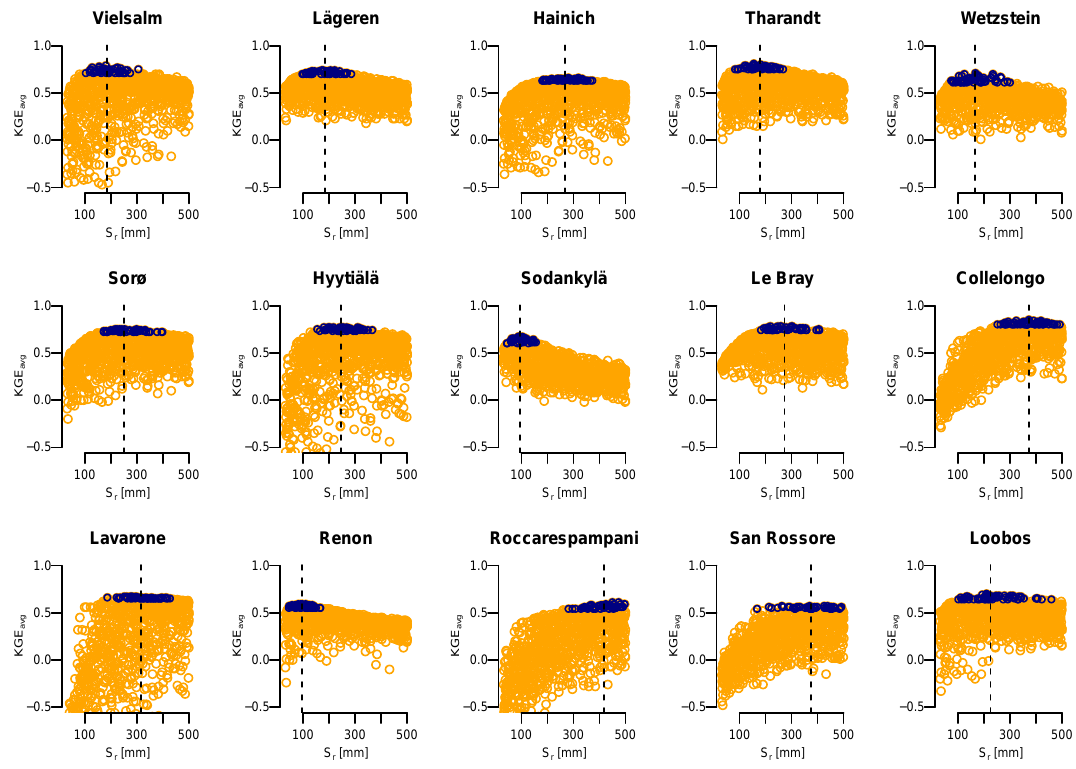
Figure 3. Relationship of the KGE avg obtained during calibration and the parameter values of S r . The dark blue points have a KGE avg greater than or equal to the 95th percentile at this site, and the line shows the median of these values (i.e., the value reported in Table 5). Although KGE avg scores lower than − 0.5 occur at some sites, the y -axis has been truncated in these graphs for clarity. At most sites, the KGE avg scores decrease faster with S r smaller than the optimal range than they do with larger S r